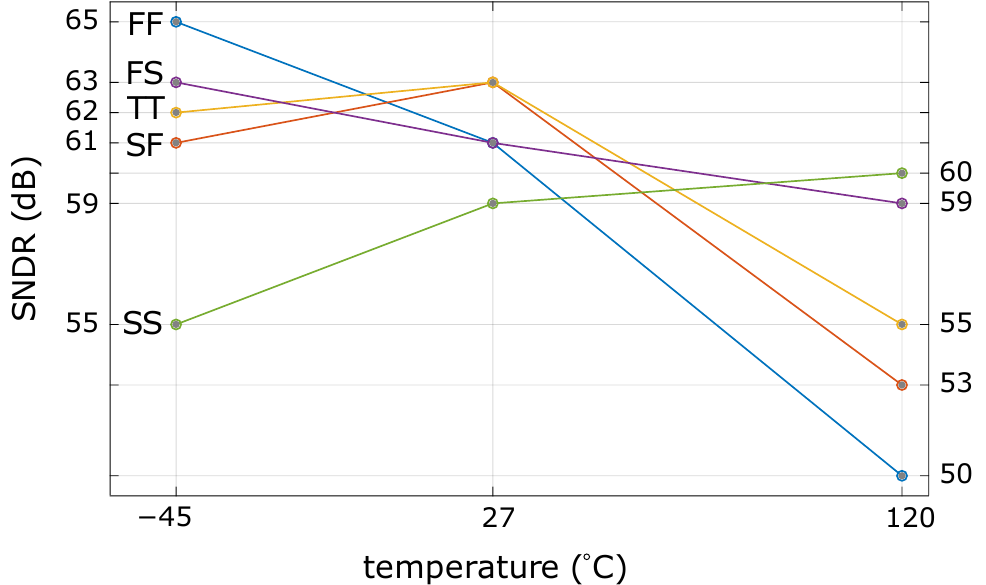
Figure 10. SNDR variation of Figure 8 due to different PVT conditions. Capital letters indicate devices’ process: ‘S’ means “slow”, ‘F’ means “fast”, and ‘T’ means typical. The first letter refers to NMOS devices and the second one refers to PMOS devices. The nominal voltage supply (1.2 V) is the same for all the